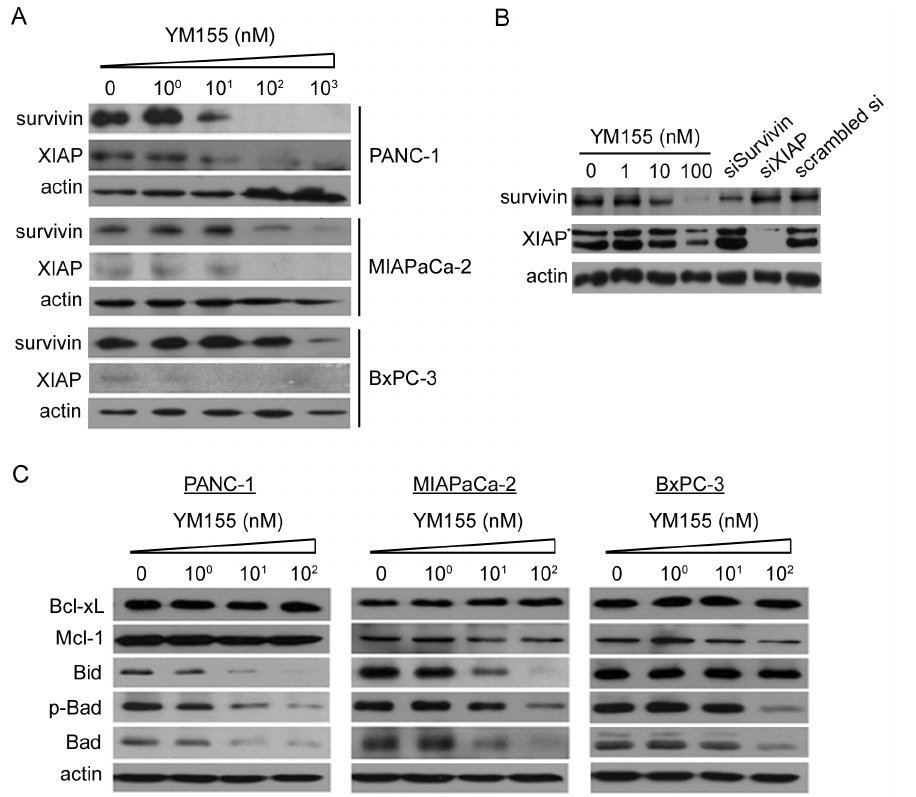
Figure 1. YM155 affects the expression of XIAP as well as survivin in pancreatic cancer cell lines, and inhibits tumor growth in MIAPaCa-2 xenograft tumor models. A, Concentration-dependent effects of a 24-hour treatment with YM155 on the expression of survivin and XIAP in PANC-1, MIAPaCa-2, and BxPC-3 cells were determined by Western blotting. B, The effect of YM155 on the expression of XIAP was compared with that of survivin knockdown by Western blotting. PANC-1 cells were treated with YM155 for 24 hours or transfected with 40 nM siRNA (siSurvivin, siXIAP, and scrambled siRNA) for 48 hours. *, nonspecific. C, Concentration-dependent effects of YM155 on the expression of anti-apoptotic (Bcl-xL and Mcl-1) and pro-apoptotic (Bid and Bad) proteins were examined in PANC-1, MIAPaCa-2, and BxPC-3